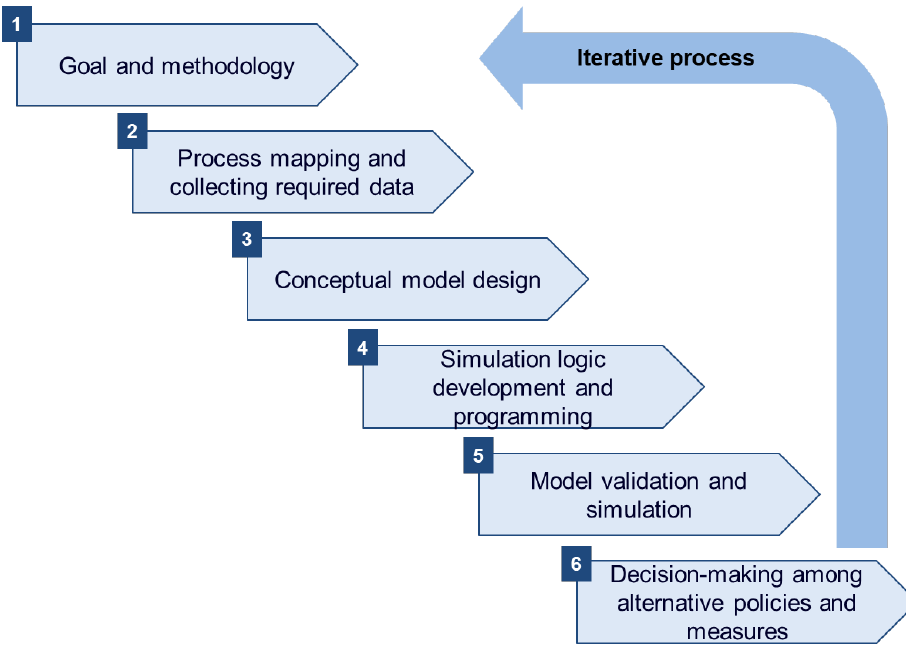
Figure 1. Research methodology.